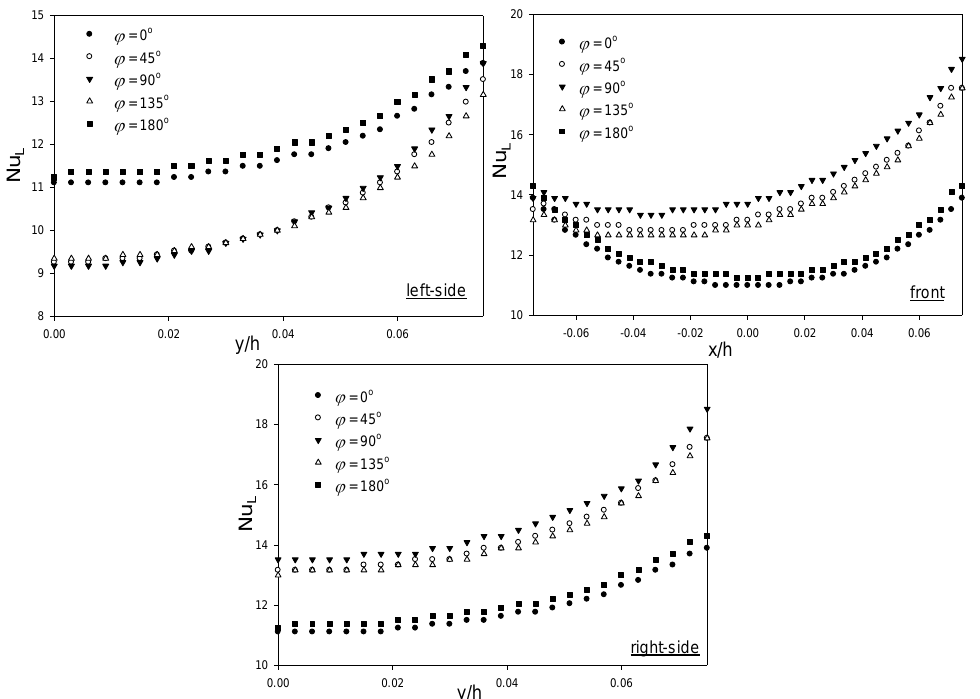
Figure 18. Variations in local Nusselt number over the left-side, front, and right-side surfaces respectively of the slender cuboid with dimensionless distance along the horizontal center-line (z/h = 0.5) at different positions when Ra * = 1 × 10 6 and W = 0.15.